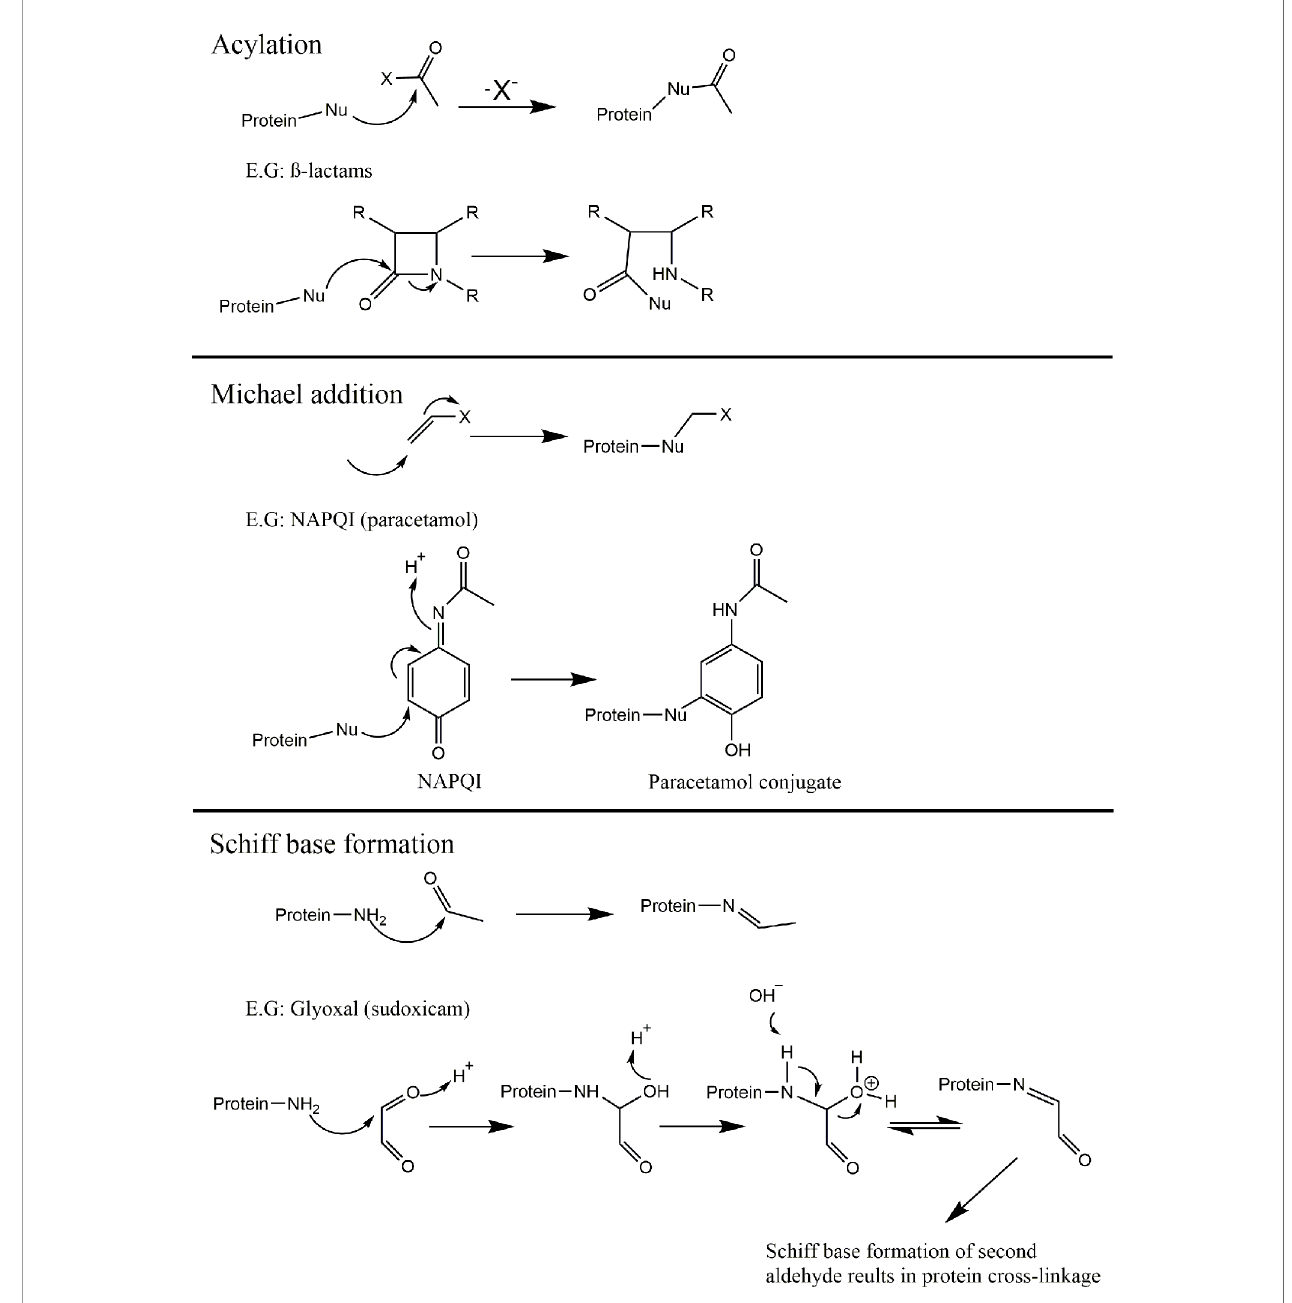
FIGURE 6 | Mechanisms of covalent binding. Outline of the 6 key mechanisms by which electrophiles react with biological nucleophiles with an example compound provided for each (continued). Acylation; B-lactam containing compounds (117). Michael addition; N-acetyl-p-benzo-quinone imine (NAPQI) (reactive metabolite derived from Paracetamol) (118). Schiff base formation; glyoxal (released via bioactivation of sudoxicam) (119,